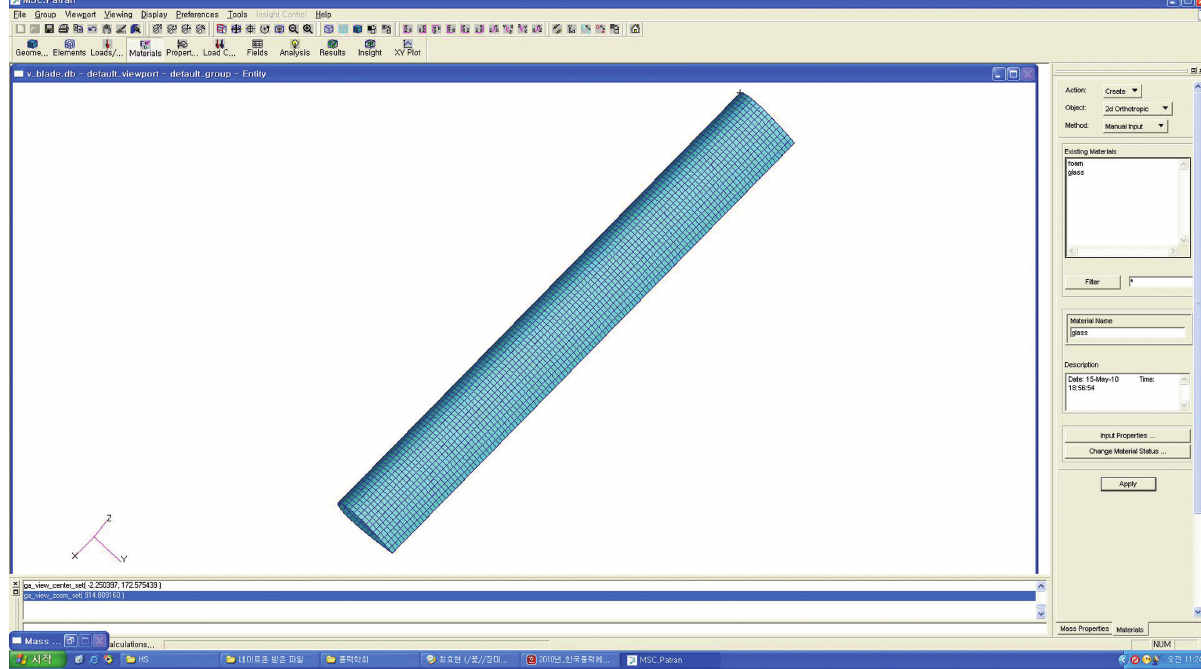
Figure 9 FE mesh generation results using PCOMP 4-node shell elements.